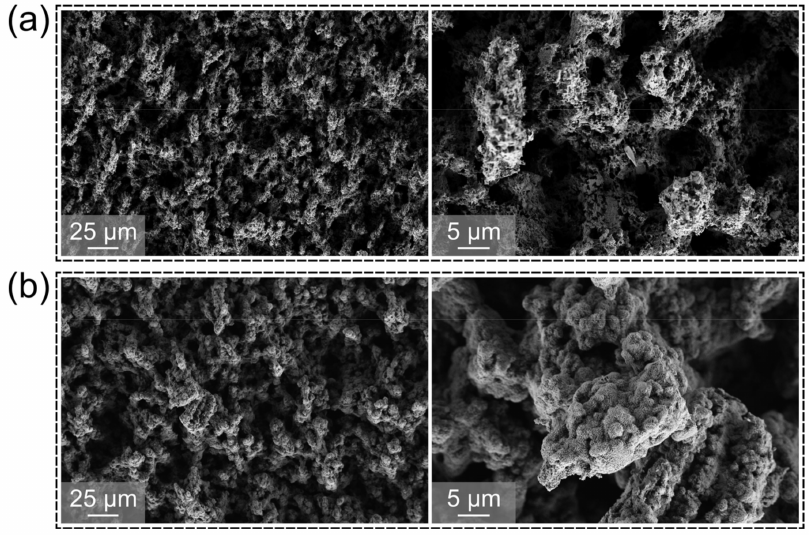
Figure 4. SEM images of the etched surface A15 before ( a ) and after boiling ( b